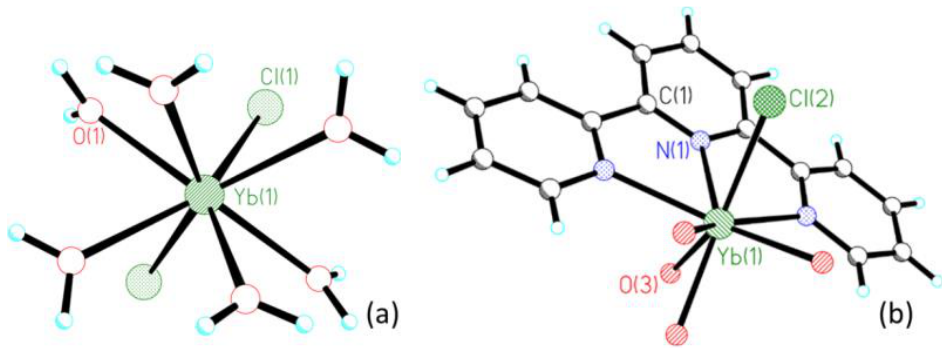
Figure 1. Structures of [Y(H 2 O) 6 Cl 2 ] + complex in compound 1Yb ( a ) and of [Yb(terpy)(H 2 O) 4 Cl] 2+ complex in 2Yb compound ( b ). Hydrogen atoms of water molecules in the structure of [Yb(terpy)(H 2 O) 4 Cl] 2+ are not shown for clarity.